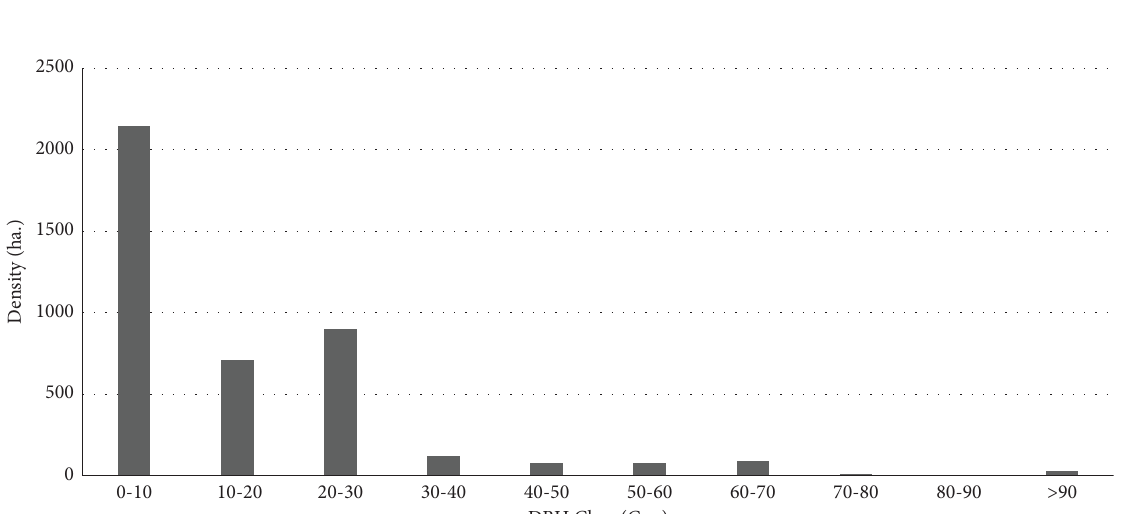
Figure 5: DBH class distribution of woody plant species in Kahitassa